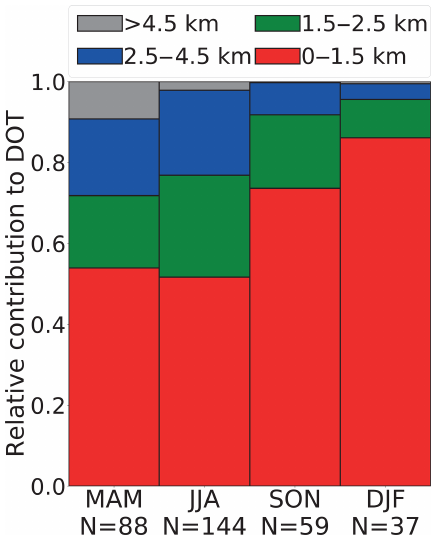
Figure 9. Seasonally resolved relative contributions of different height regions to DOT (532nm). The analysis is based on the data shown in Fig. 8c and the respective height profiles of the particle extinction coefficient. Numbers of available observations are given in the lowest line. The figure is similar for AOT (not shown).